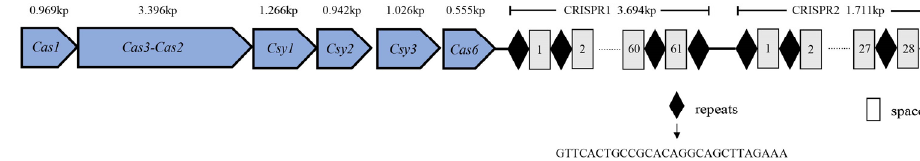
Figure 6. The type IF CRISPR-Cas locus of Legionella pneumophila strain Corby (ICDC). Table 3. Coding products of partially spacer-matched genes in the CRISPR-Cas system of Legionella pneumophila strain Corby